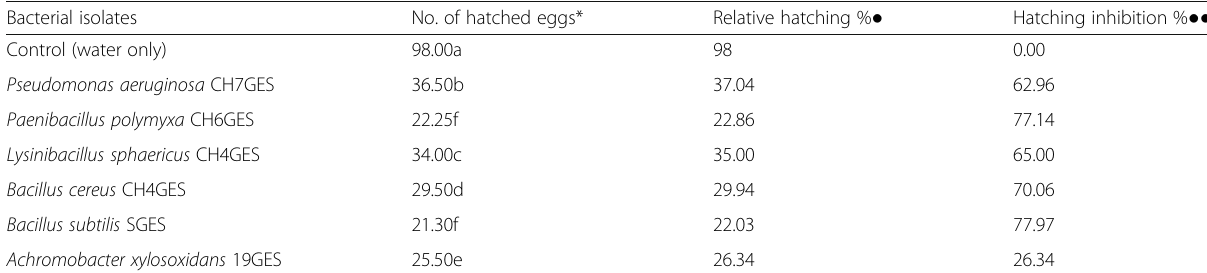
Table 2 Inhibition activity of the culture filtrates of the isolated bacterial strains on Meloidogyne incognita eggs after 7 days of exposure Bacterial isolates